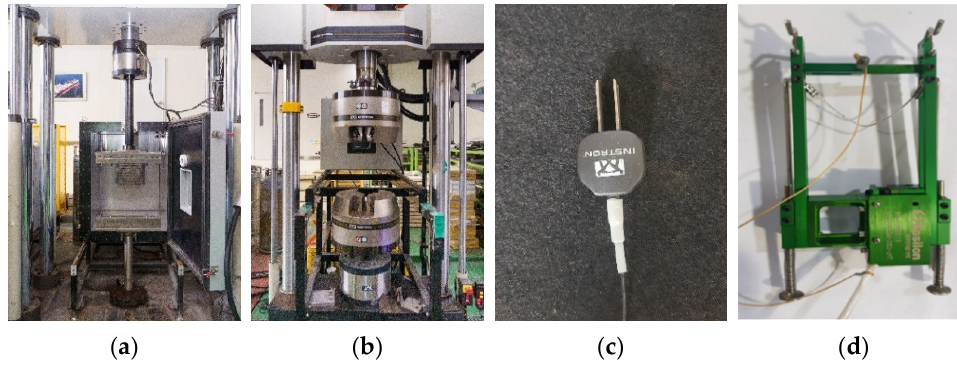
Figure 2. Testing machine: ( a ) IST 8800; ( b ) IMT 8803; ( c ) COD gauge; ( d ) Extensometer.